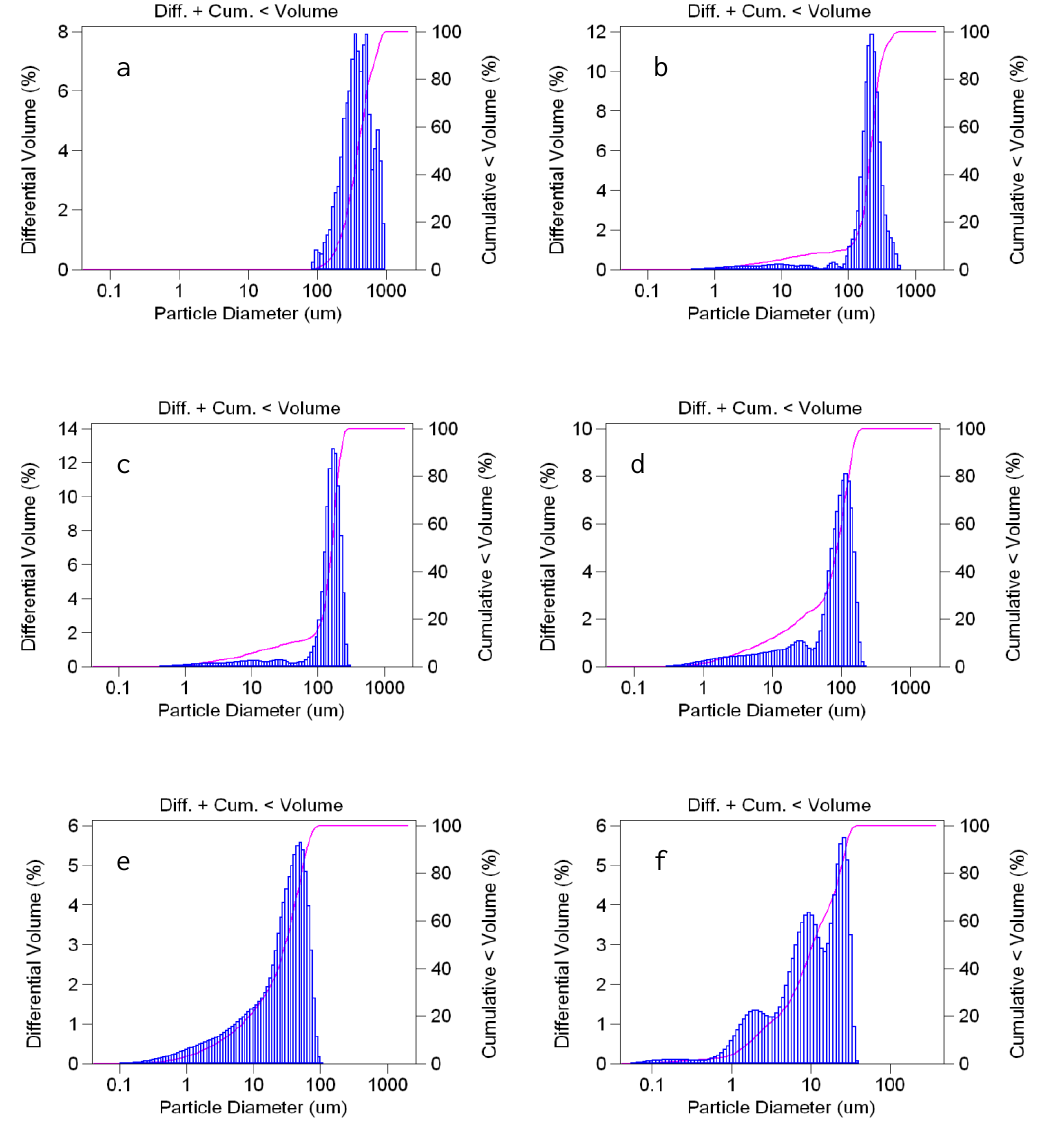
Figure 3 . The effect of the ball-milled time on the mean size of crayfish carapace particles. The duration of ball-milled time is 0 min (a), 20 min (b), 40 min (c), 60 min (d), 80 min (e), and 100 min (f). The pink line means cumulative particle size distribution of CCM and the blue shaded regions means particle size distributions of